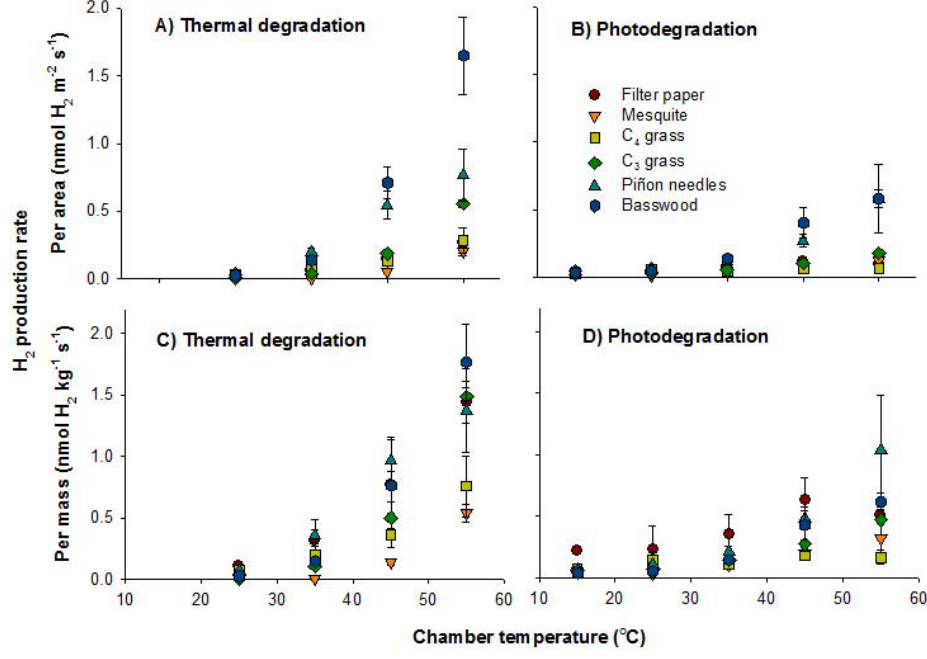
Fig. 2. The rate of H 2 production from abiotic degradation of plant litter across a range of temperatures. Abiotic degradation is divided into (a) and (c) thermal degradation (H 2 production in the absence of solar radiation minus blank) and (b) and (d) photodegradation (H 2 production in the presence of solar radiation minus thermal degradation). Six plant litter types were used. Means and standard error ( n = 3) are depicted.